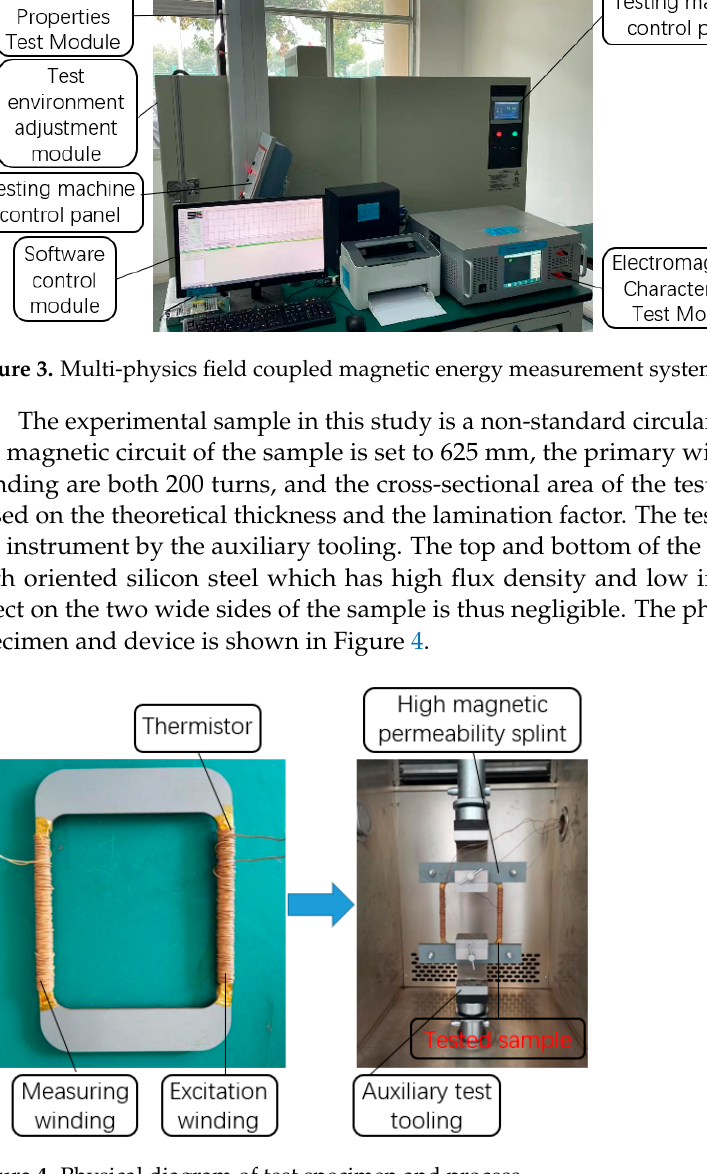
Figure 4. Physical diagram of test specimen and process.